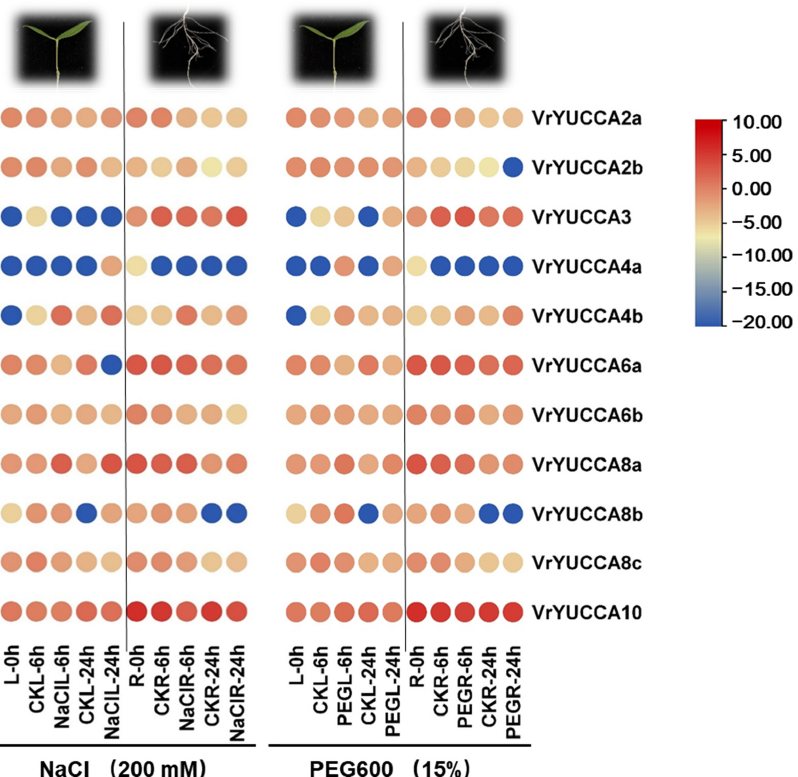
Figure 7. VrYUCCA genes expression during salt and drought stress. Values (RNA-seq data), in fragments per kilobase of transcript per million reads mapped (FPKM), used logarithm (LOG 2) for the heat map. L: leaf; R: root.